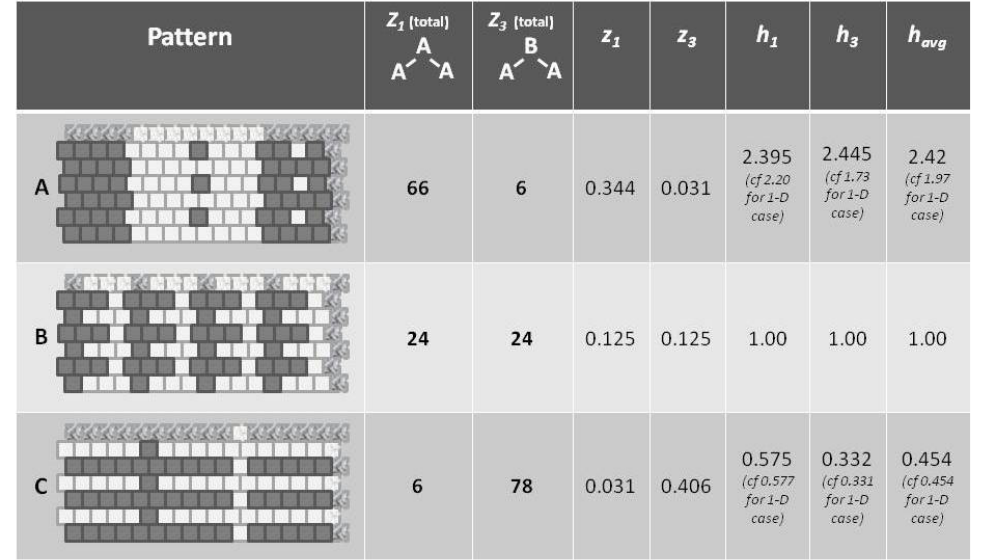
Figure 9. Replicating the kind of patterns shown previously for the 1-D CVM, the same patterns are extended to the 2-D CVM system. The actual fractional values for the various triplets are the same as for those used in the previous 1-D CVM